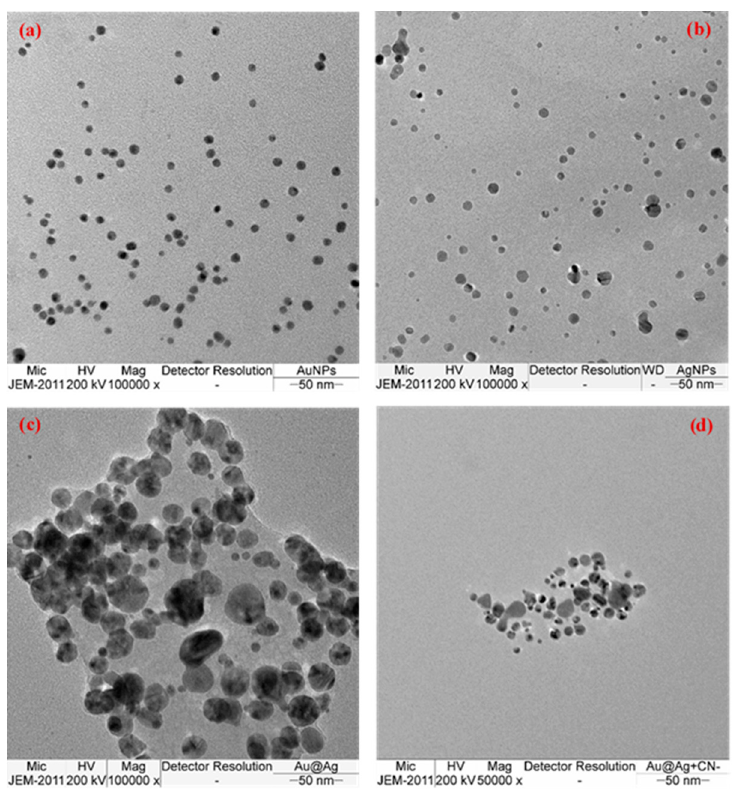
Figure 2. TEM images for ( a ) AuNPs, ( b ) AgNPs, ( c ) Au@Ag NPs and ( d ) Au@Ag NPs in the presence of 20 mg L − 1 CN − .